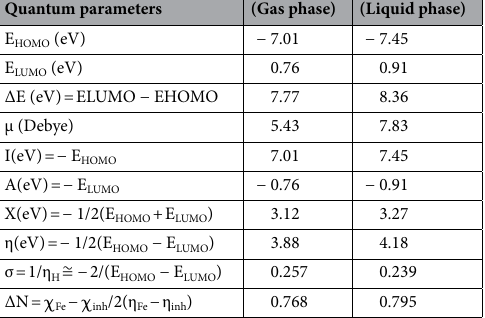
Table 5. Quantum chemical calculated parameters of the investigated CS4